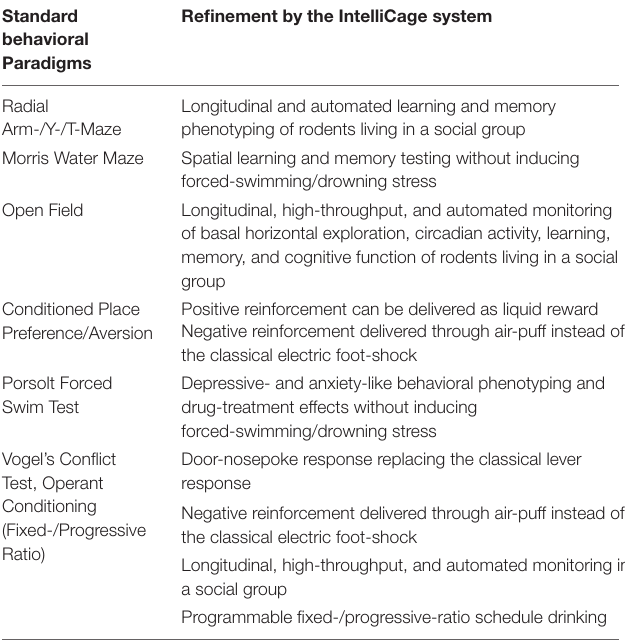
TABLE 1 | Summary of refinement by the IntelliCage system compared to standard behavioral